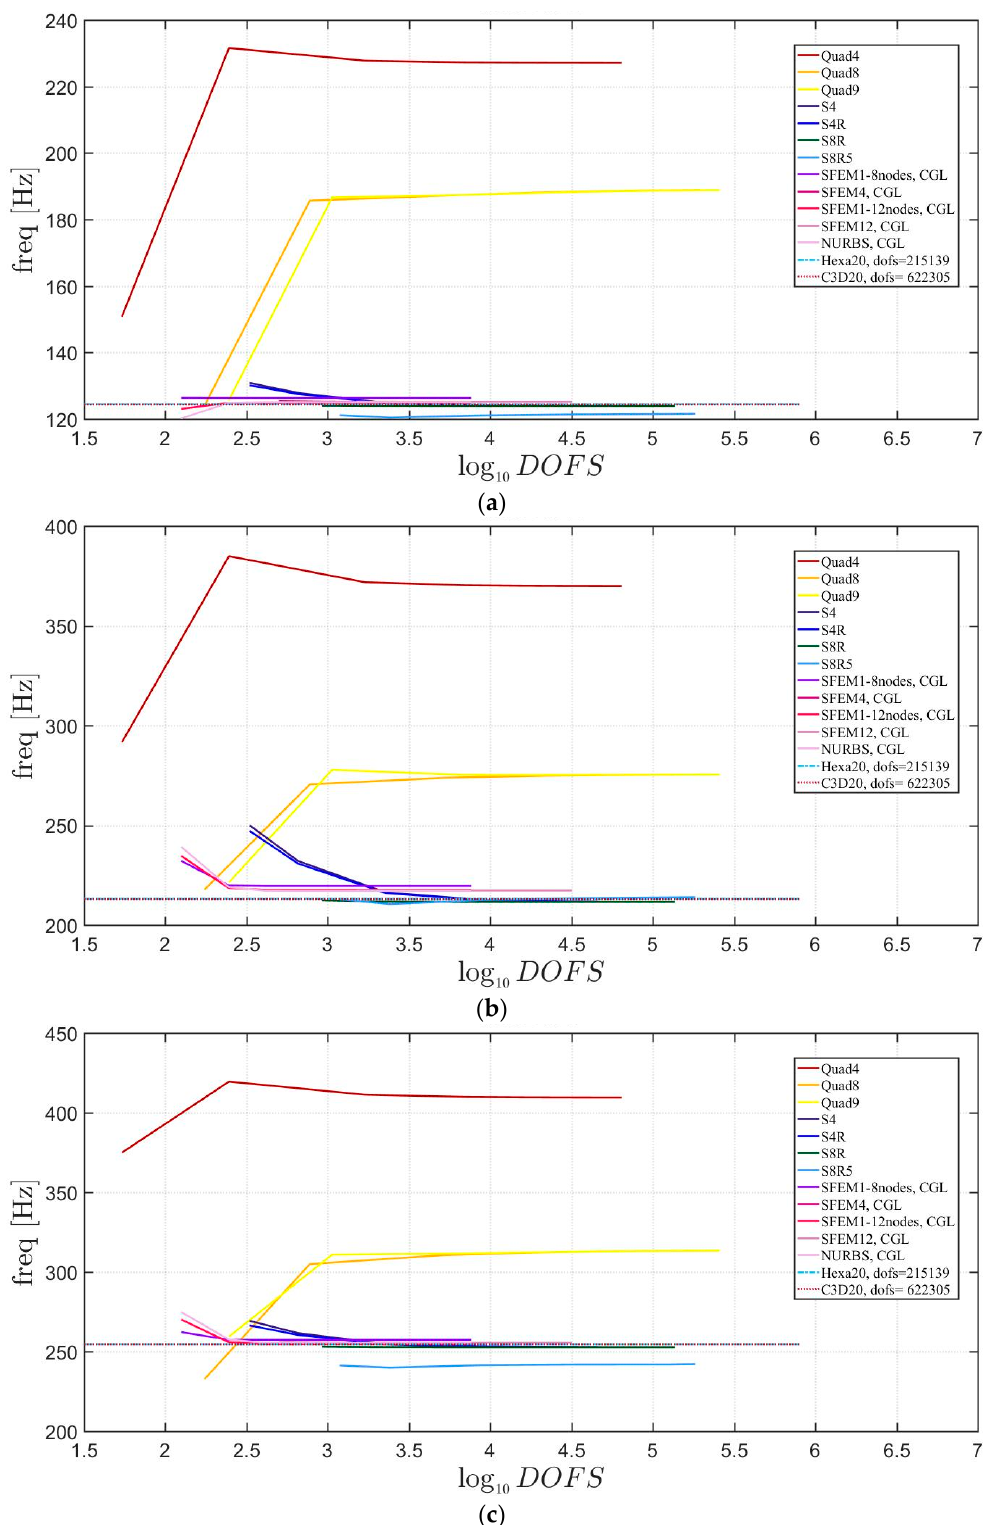
Figure 23. First three natural frequencies of an elliptic plate with a / b = 1.5 a symmetric lamination scheme and a / h = 10: ( a ) First frequency; ( b ) Second frequency; ( c ) Third frequency.